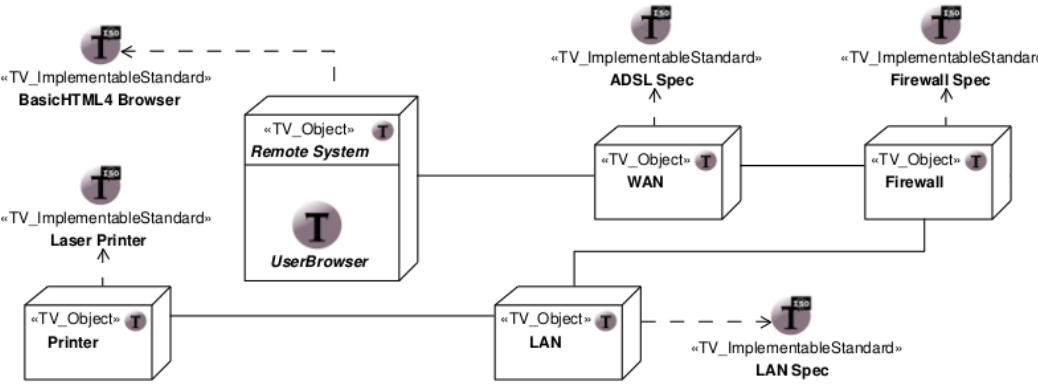
Figure 7. Implementation standards with their respective technologies. Source: